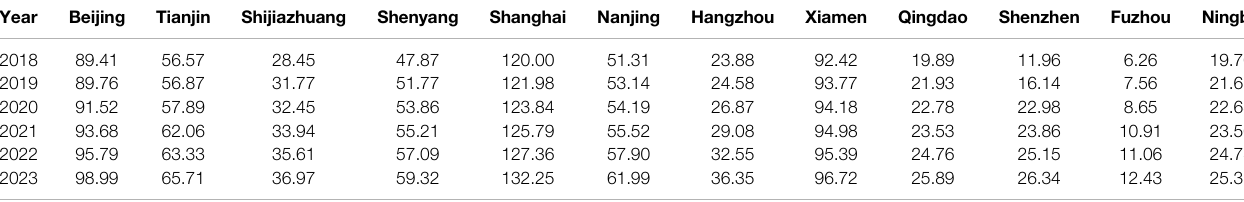
TABLE 3 | Forecast trends in urban household electricity consumption in the Eastern Region (billion kWh).